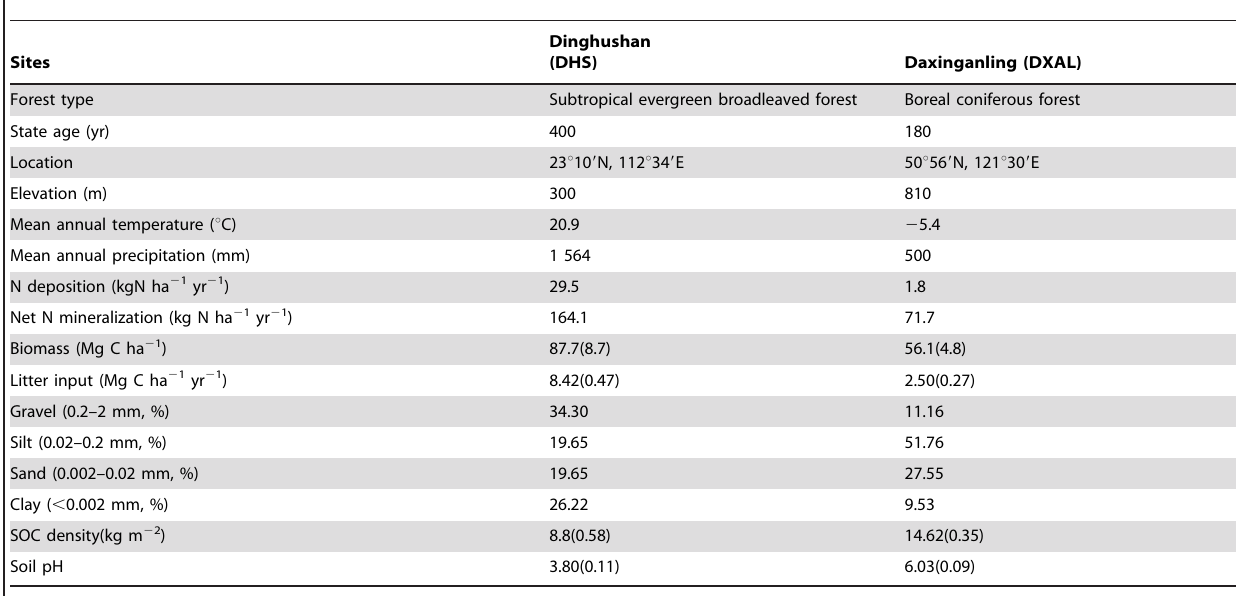
Table 1. Stand characteristics and surface soil (0–20 cm) properties at the two old-growth forest